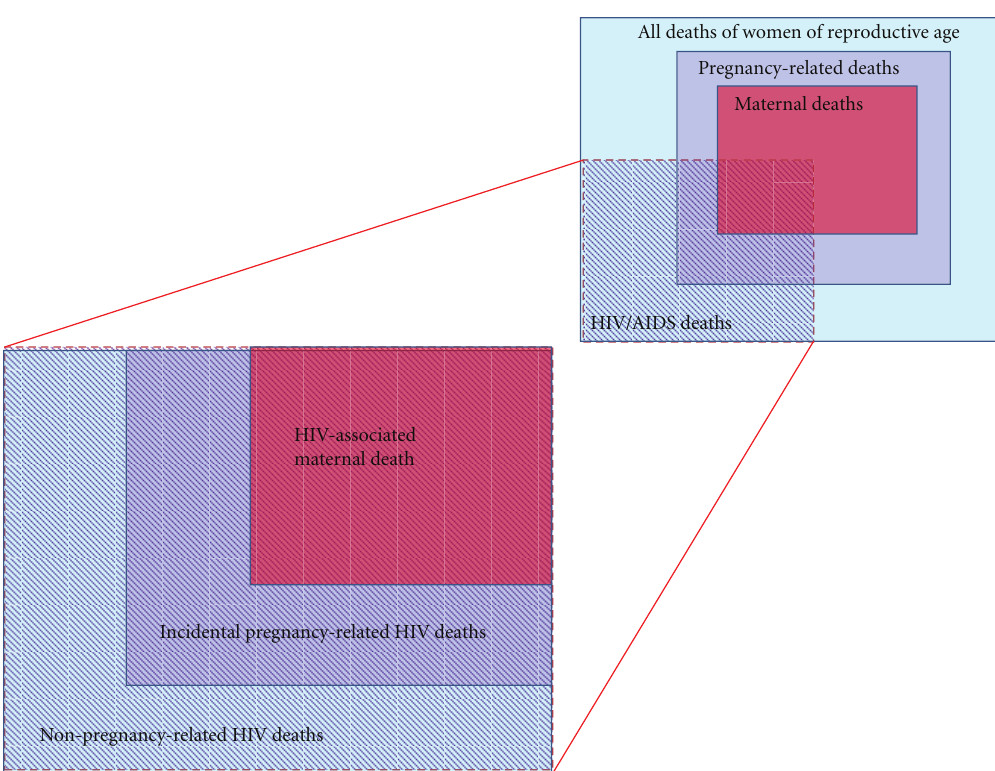
Figure 1: The intersecting epidemics of HIV and maternal